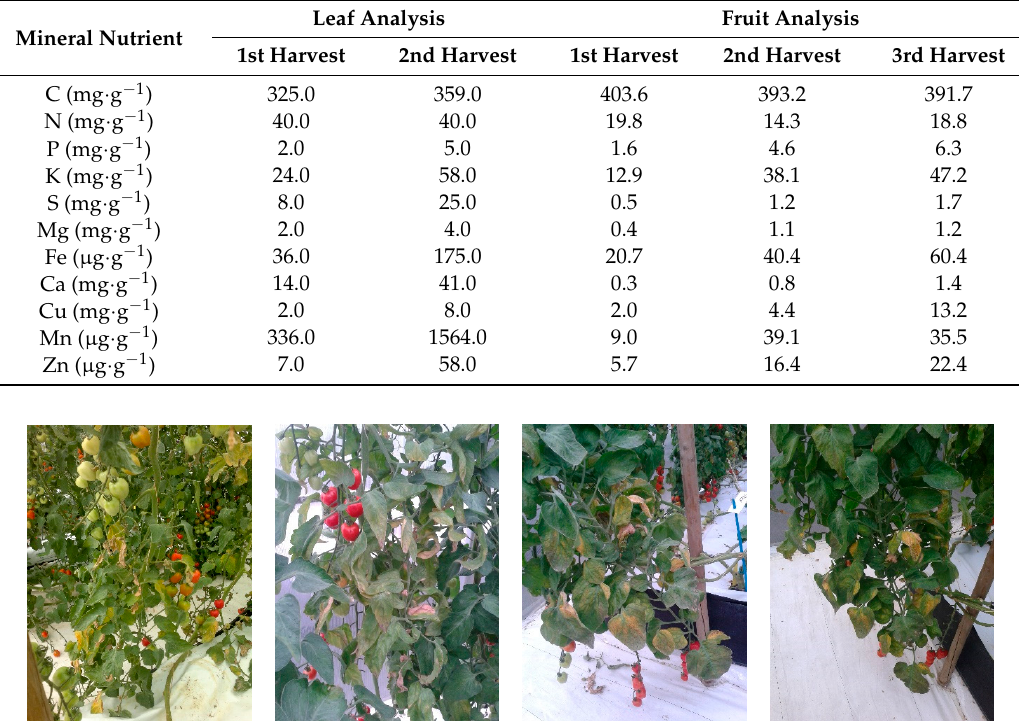
Figure A1. Tomato plants in raft culture subunit (C9) affected by spider mites at the end of June 2014.